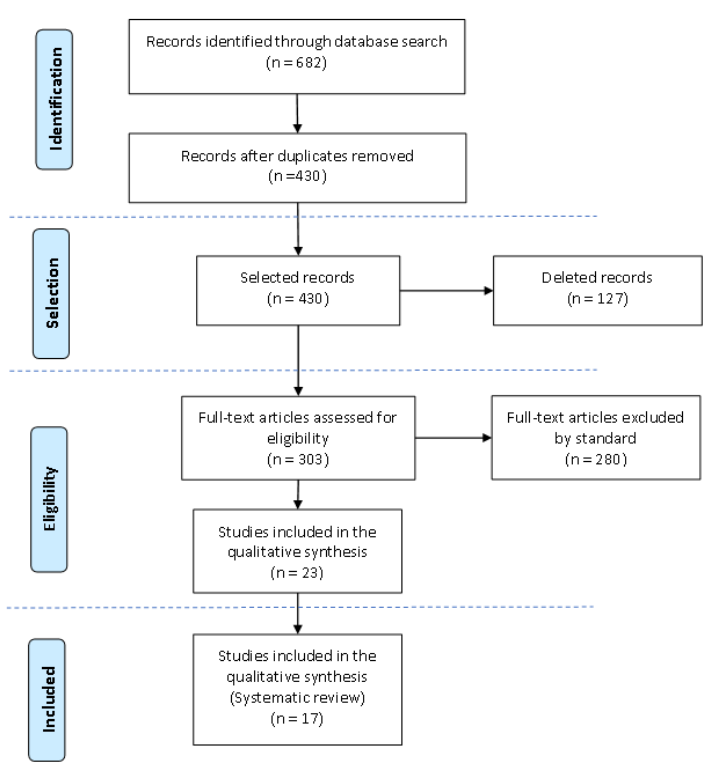
Figure 1. Analysis flowchart used in the development of the systematic review.